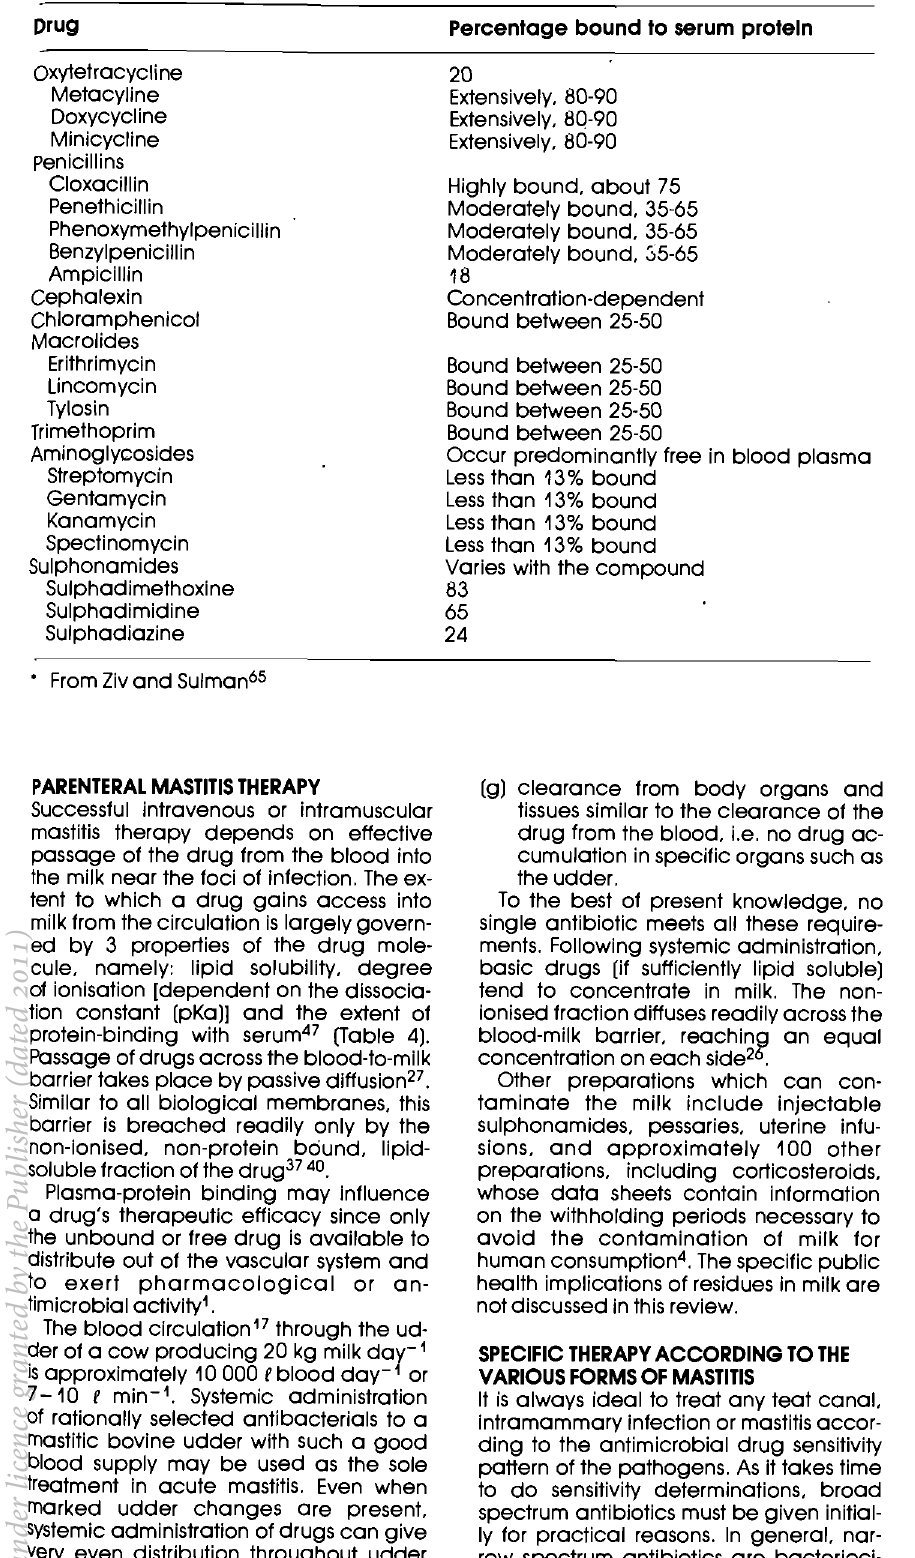
Table 4: Binding of antibiotics and sulphonamides in bovine serum